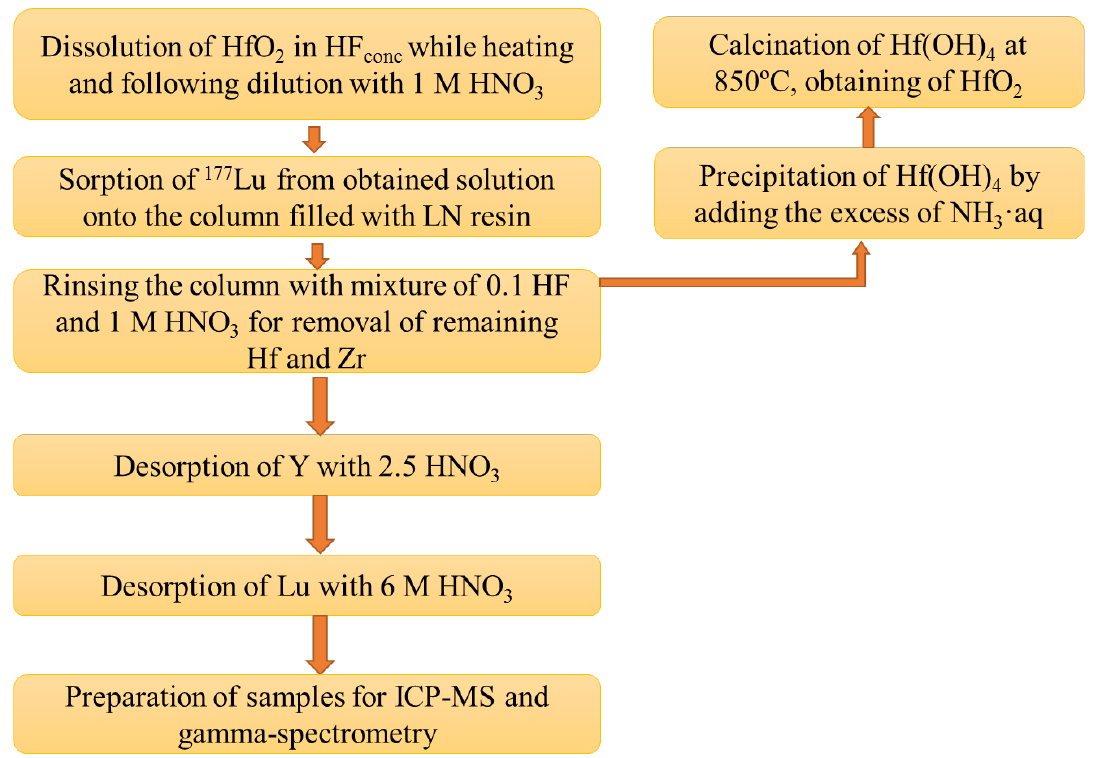
Figure 1. Scheme of developed method of 177 Lu recovery after its production in electron accelerators and regeneration of HfO 2 .